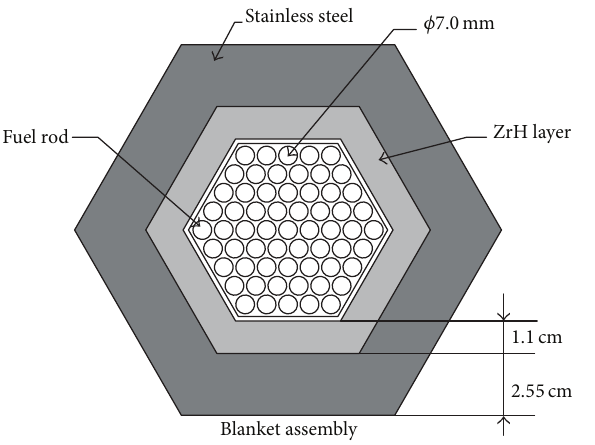
Figure 1: A typical SCFR blanket assembly design.